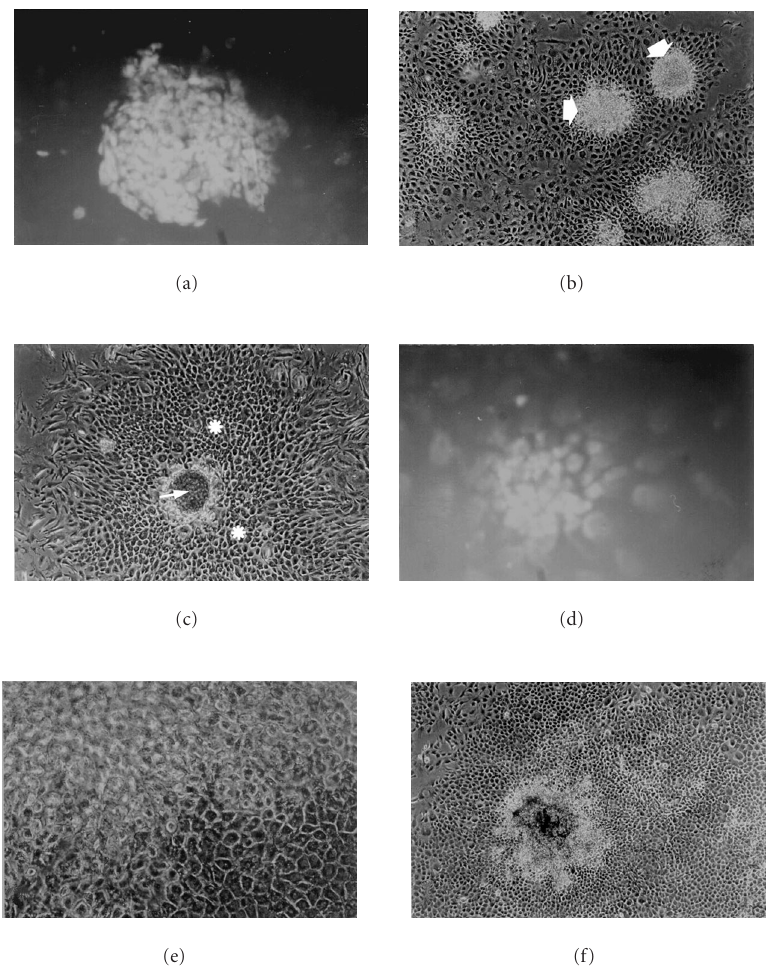
Figure 2. (a) Immunofluorescence of type II collagen shows intense labelling in aggregates cultured in suspension, OM 25 X. (b) Aggregates transferred onto plastic form stable plates of di ff erentiated chondrocytes with cartilaginous nodules (arrow), OM 25 X. (c) A cartilaginous nodule with central round cells (arrow), intermediate polygonal cells (asterisk), and peripheral fibroblastic and polymorphic cells, OM 25 X. (d) Type II collagen is extensively produced by round and polygonal cells, OM 25 X. (e) Addition of aggregates to dedi ff erentiated monolayer cultures; note the extensive presence of round cells surrounded by extracellular matrix (up- per) and polygonal cells surrounded by a refractile matrix (lower), OM 50 X. (f) Addition of aggregates to dedi ff erentiated monolayer cultures; positive alcian blue staining, OM 25